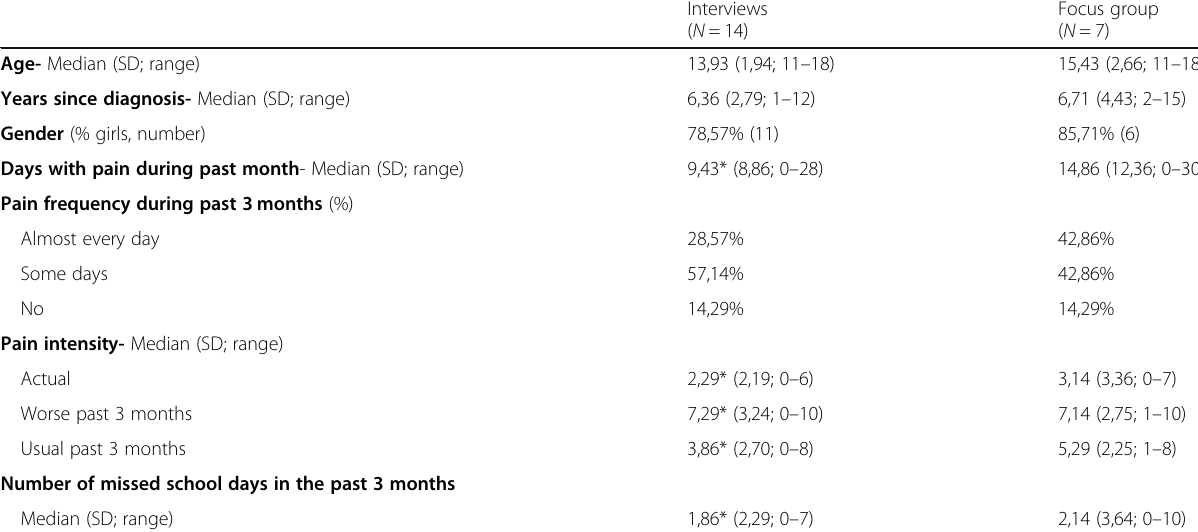
Table 3 Sociodemographic and pain